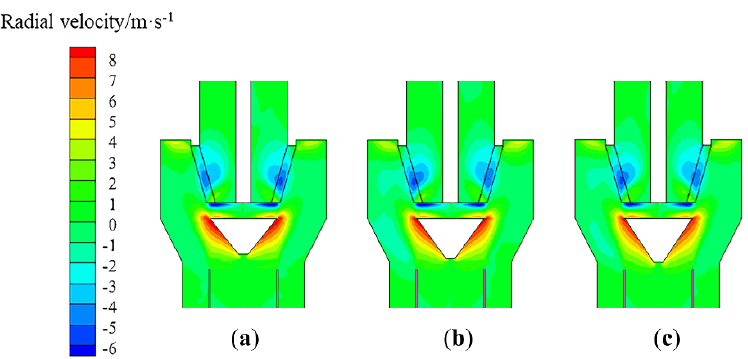
Figure 18. Effect of the height of the diversion cone on the radial velocity (T-D (1-0.7) , x = 0): ( a ) h = 94 mm, ( b ) h = 104 mm, and ( c ) h = 114 mm.